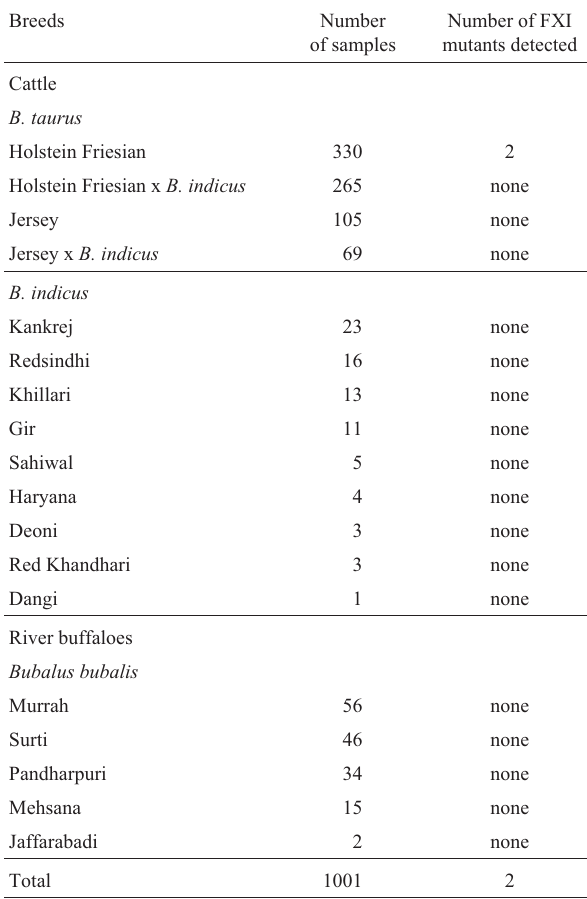
Table 1 - Details of the samples collected from different breeds of Bos taurus,Bosindicus and B.taurusxB.indicuscrossbred cattleandtheriver buffalo Bubalus bubalis . (All the animals were bulls).